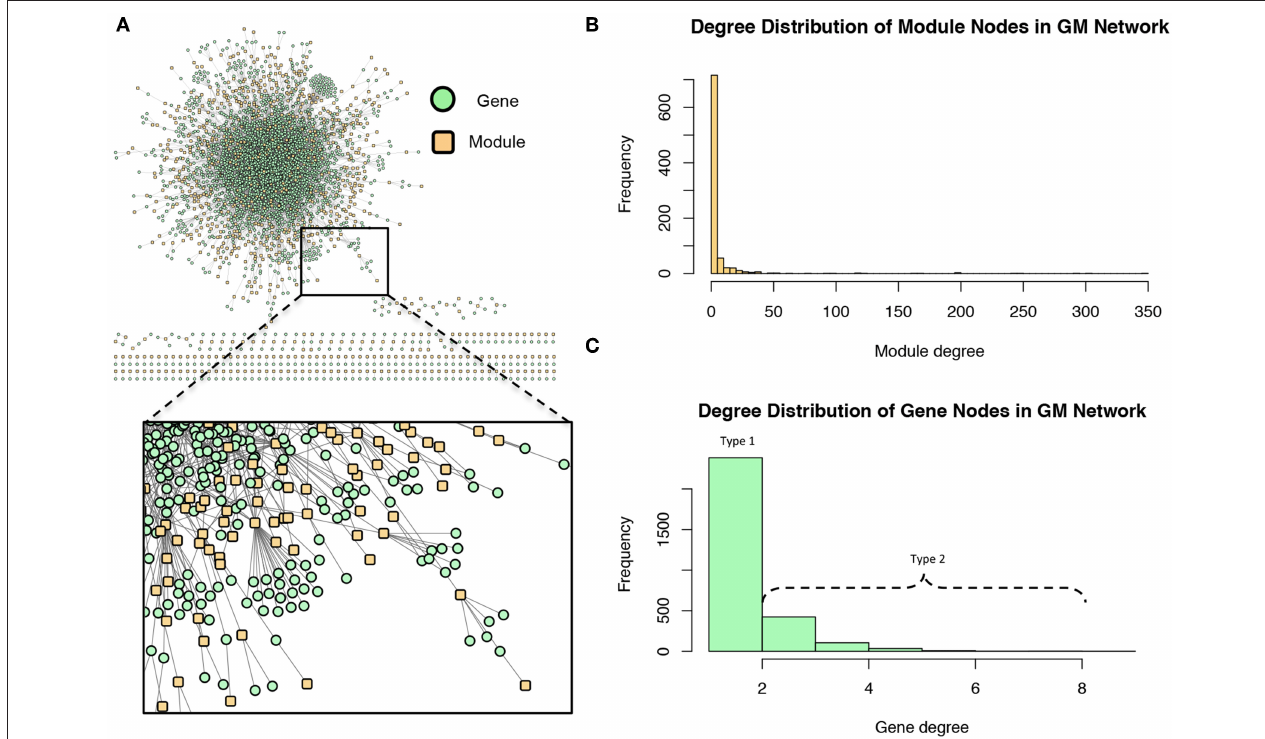
FIGURE 8 | Gene-module ( GM ) network. (A) The GM network. Green nodes represent MPA genes and yellow nodes represent association modules. A gene node is connected to a module node if the module contains a SNP which resides within that gene. (B) Degree distribution of the module (yellow) nodes in the GM network. (C) Degree distribution of the gene (green) nodes in the GM